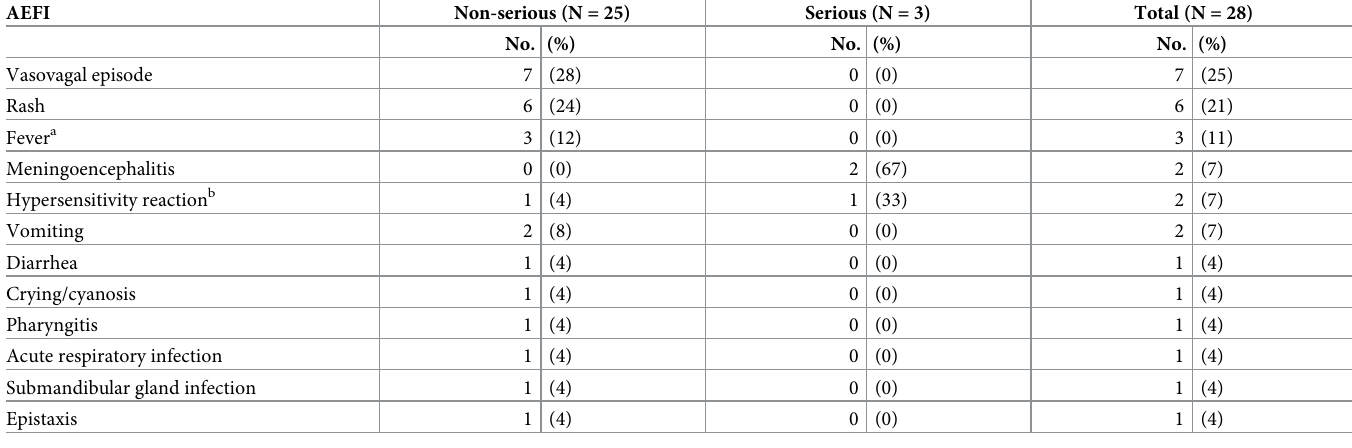
Table 1. Non-serious and serious adverse events following administration of SA14-14-2 JE vaccine to 309,507 children aged 9 months–12 years during an immuni- zation campaign in Cambodia,